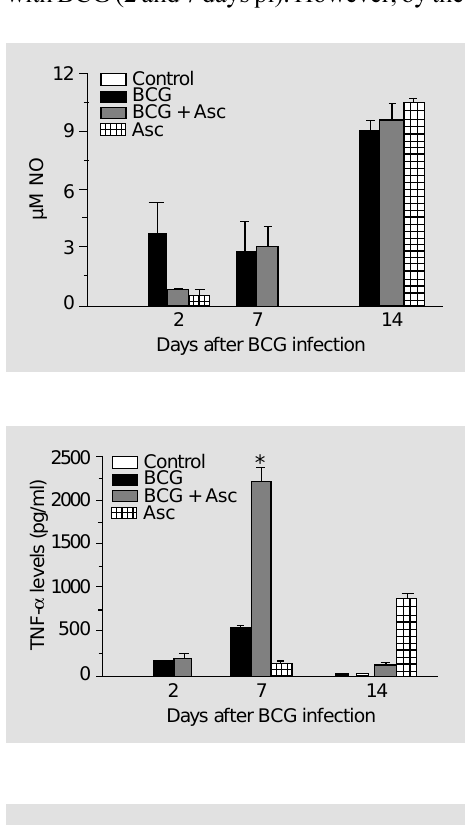
Table 1 – Frequencies of IFN- g spot-forming cells (SFC) in C57Bl/6 at 7 days pi. Results are reported as mean ± SD of one repre- sentative experiment with duplicate measure- ments per data point. *P<0.05 compared to BCG and BCG + Asc (Student t -test).